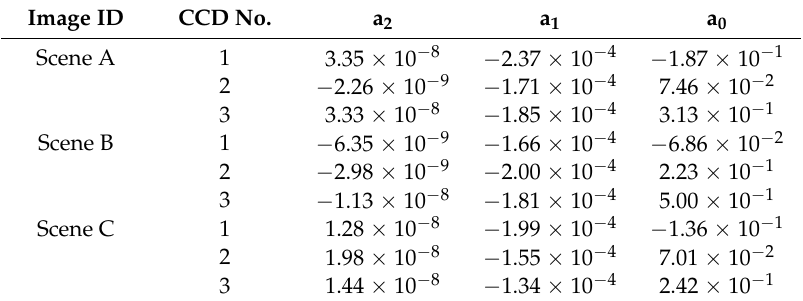
Figure 12. Parallax images across the track between B2 and B3 of ( a ) Scene A, ( b ) Scene B, and ( c ) Scene C. Table 6. Estimated polynomial coefficients of the relative systematic error across the track between B2 and